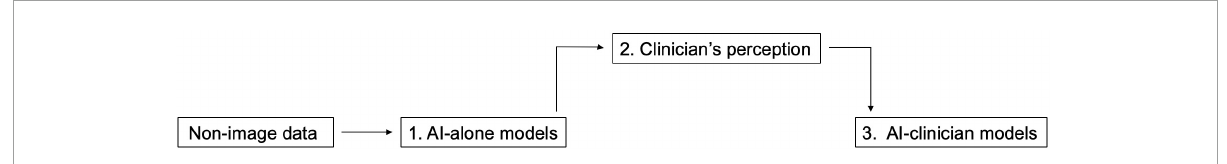
FIGURE1 Schematic view of the development of the AI-alone and AI-clinician models. (1) AI-alone models based on non-image data. (2) Clinician perception derived from AI-alone models. (3) AI-clinician models with clinician